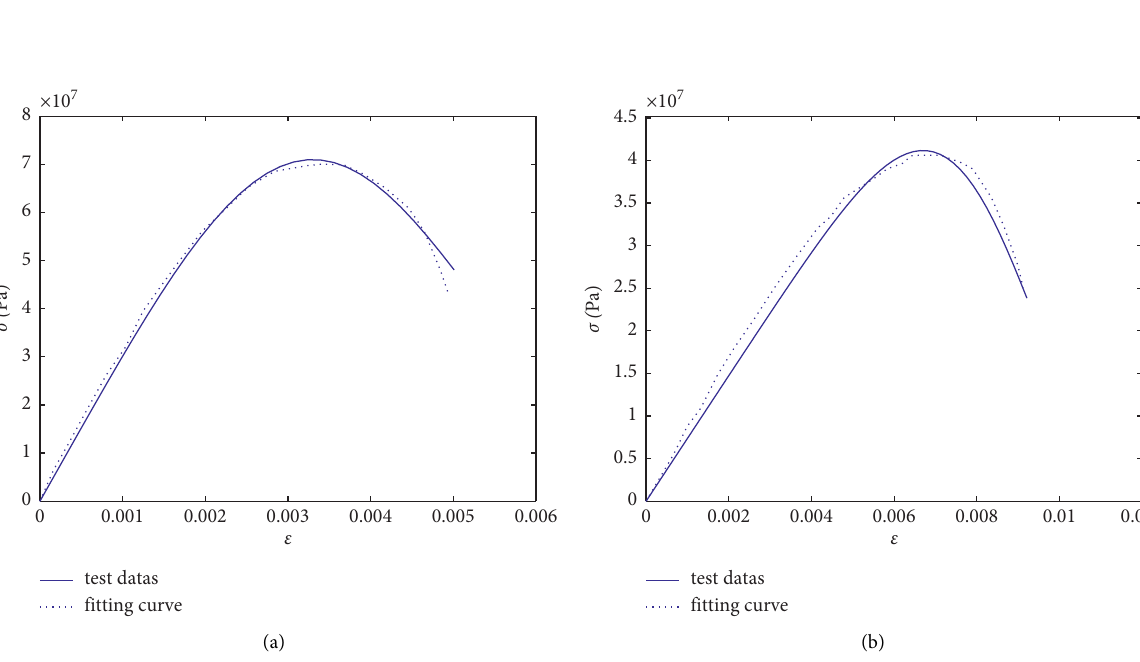
Figure 15: Calculation curve and experimental data. (a) Freeze-thaw cycle is 0; axial pressure is 0MPa. (b) Freeze-thaw cycle is 20; axial pressure is 20 MPa; launch air pressure is